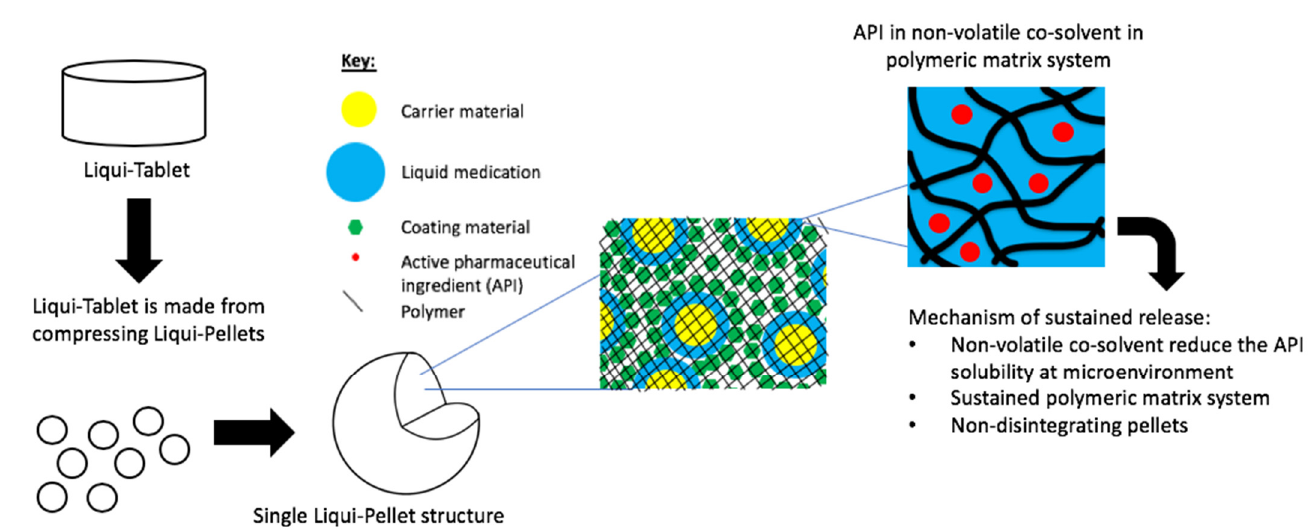
Figure 1. General structure of sustained-release Liqui-Tablet.